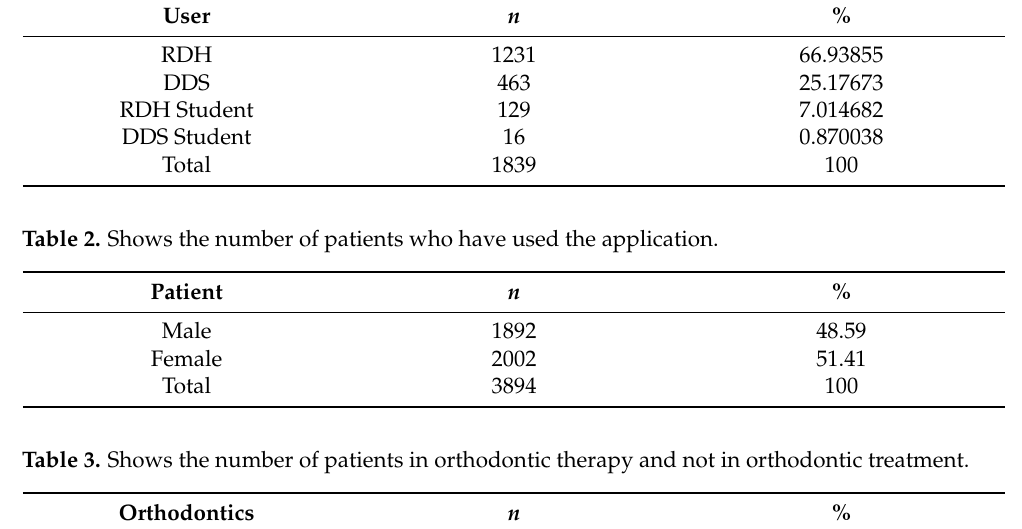
Table 3. Shows the number of patients in orthodontic therapy and not in orthodontic treatment. Orthodontics n % No treatment 3310 Multibracket